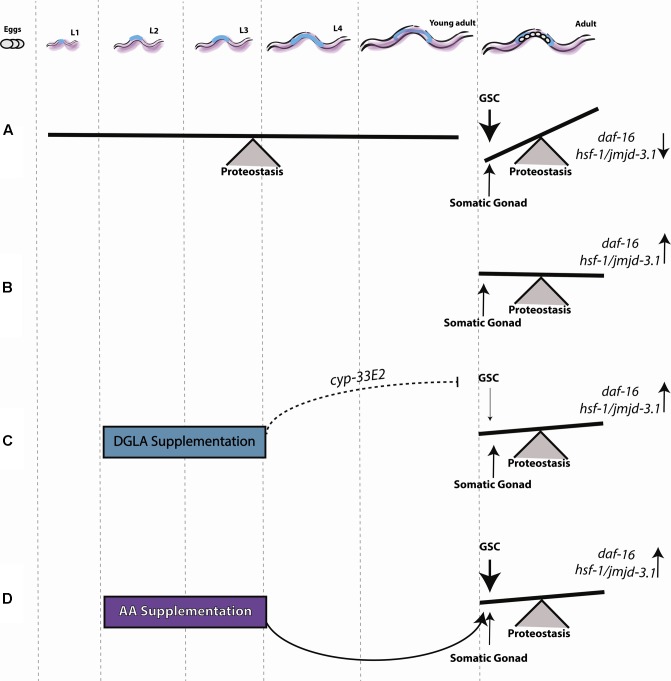
Early signals from the reproductive system determine somatic maintenance. (A) Proteostasis of young adult animals is robust, showing low levels of protein damage, effective activation of stress responses and high rates of stress survival. Following the onset of reproduction, signals from GSCs activate a regulatory switch that changes the proteostatic capacity of the soma. (B) Inhibiting GSC proliferation induces sterility and allows the organism to maintain robust proteostasis by somatic gonad signals, as seen in young animals. (C) DGLA supplementation during the L2–L4 stage has a beneficial effect on proteostatic collapse, depending on somatic gonad function, and a negative effect on fecundity. (D) AA supplementation during the L2–L4 stage has a beneficial effect on proteostasis during adulthood.